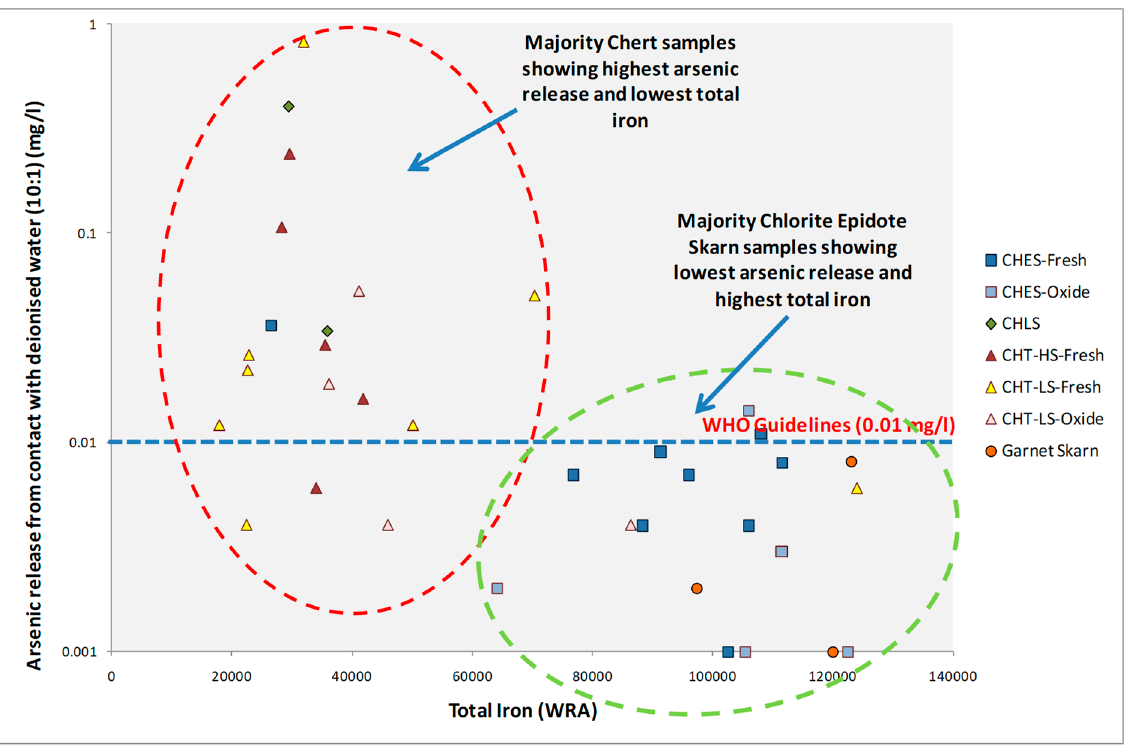
Figure 12. Plot of arsenic release from the deionised leach test against total iron from the whole rock assay.